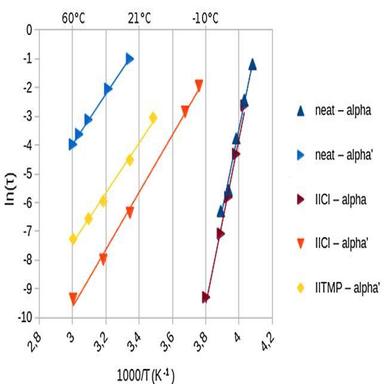
Arrhenius plots for the described relaxations. All linear regression fits are obtained with a squared correlation coefficient superior to 0.99. Similar results were obtained for the conductivities.